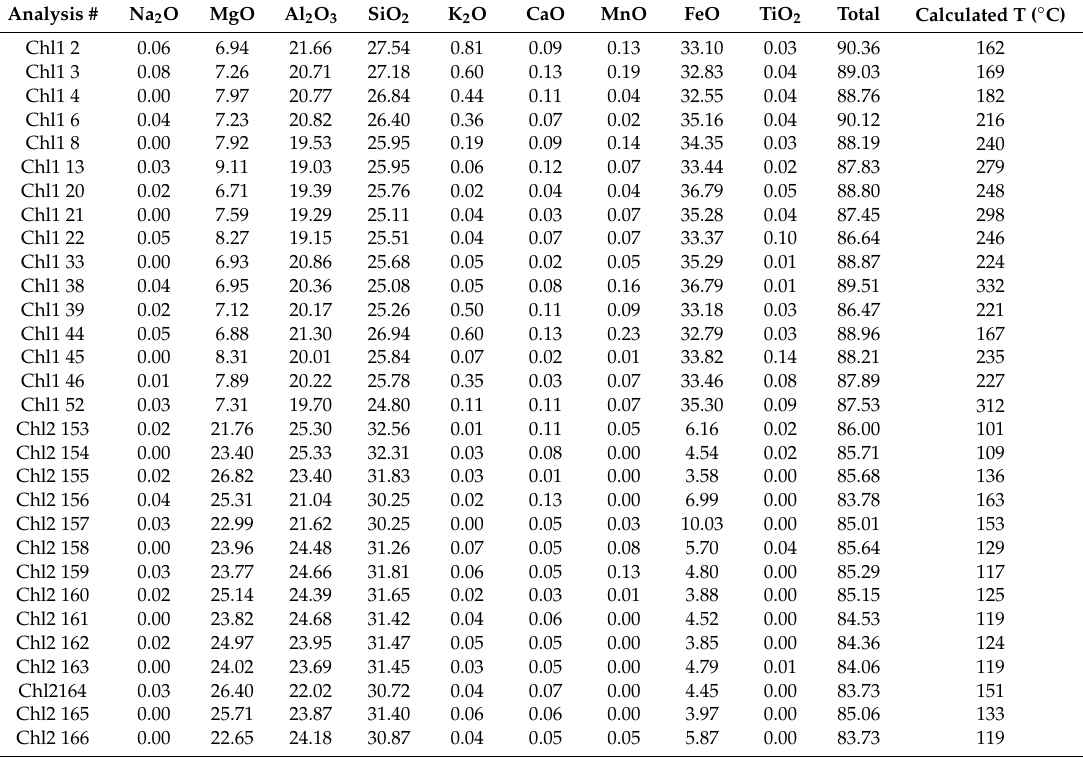
Table4. Chemicalcomposition(wt.%)andcalculatedtemperature[50]ofchloriteChl1andChl2(EPMA).